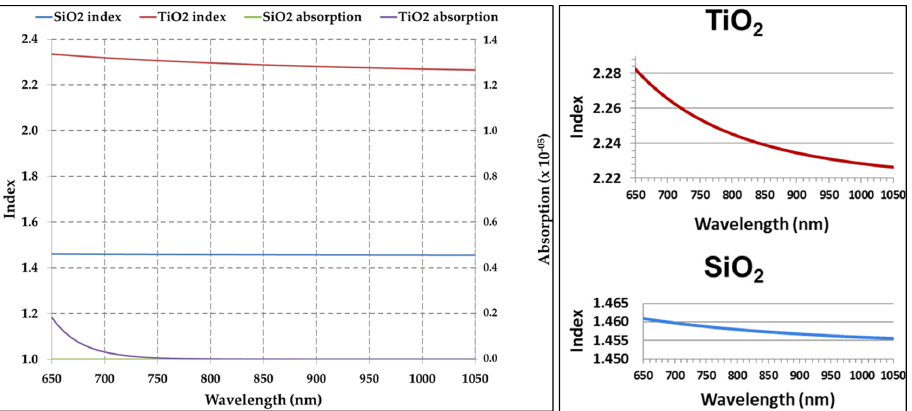
Figure 2. Index of refraction and absorption as functions of wavelength for the SiO 2 and TiO 2 coating layers. The inserts to the right show the index data on expanded scales. Absorption is k where 4 π k/ λ is the optical absorption coefficient.